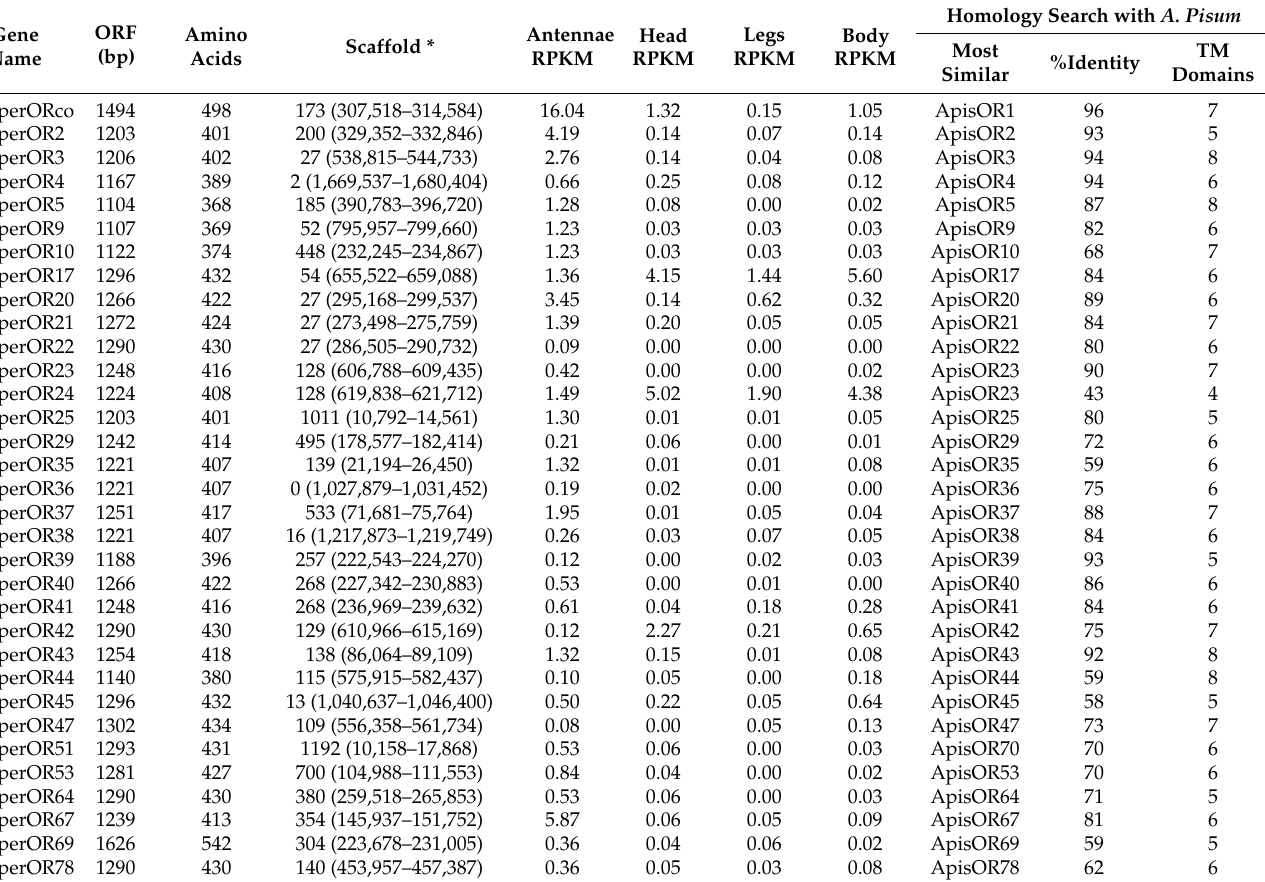
Table 1. List of OR genes in M. persicae